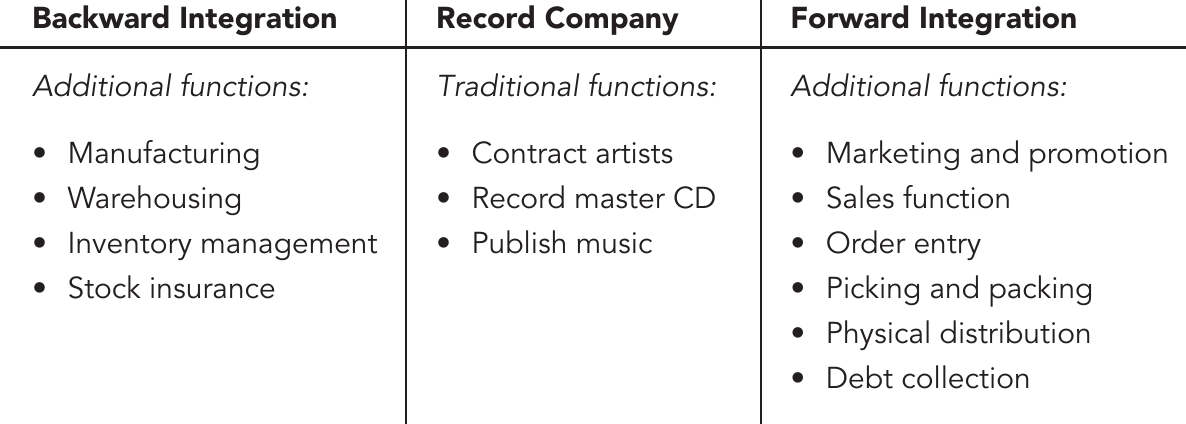
Table 1: A simple supply chain of the recording industry Backward Integration Record Company Forward Integration Additional functions: Traditional functions: Additional